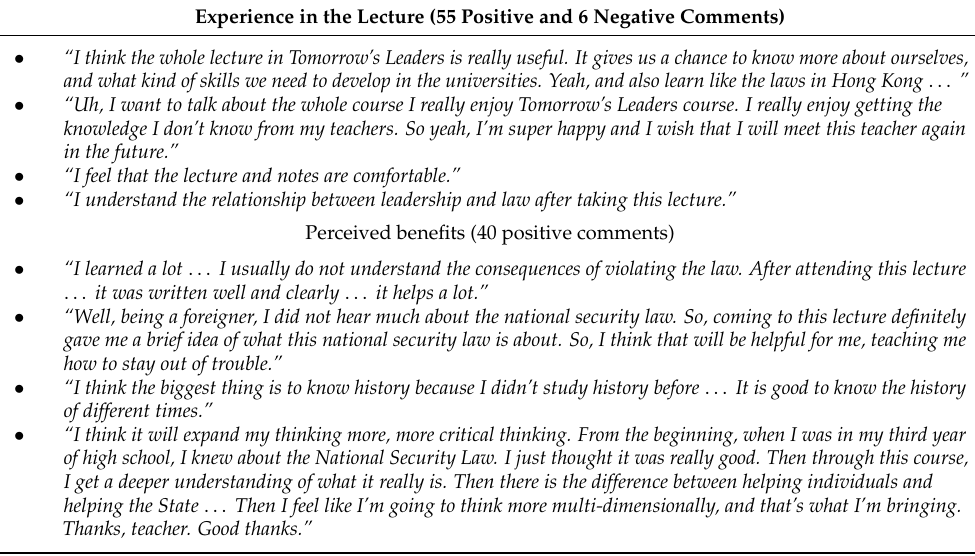
Table 4. Narratives of positive views on the experience in the lecture and perceived benefits.